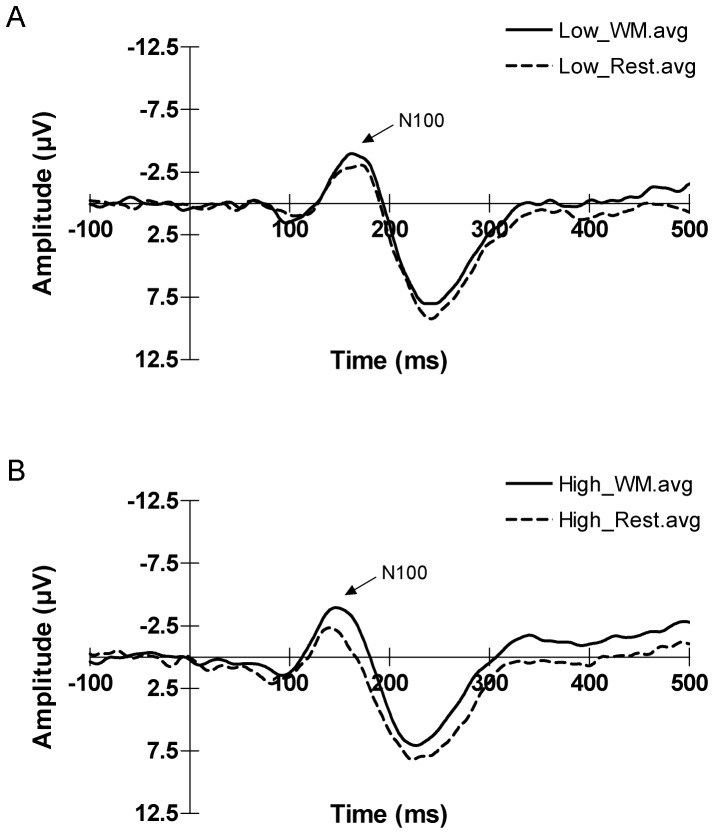
Overall average N100-AEP waveforms of the mid-frontal region.A: Waveforms of the low WM load task; B: Waveforms of the high WM load task. Solid lines represent the average N100-AEP waveform in the WM state; dotted lines represent the average N100-AEP waveform in the rest state.